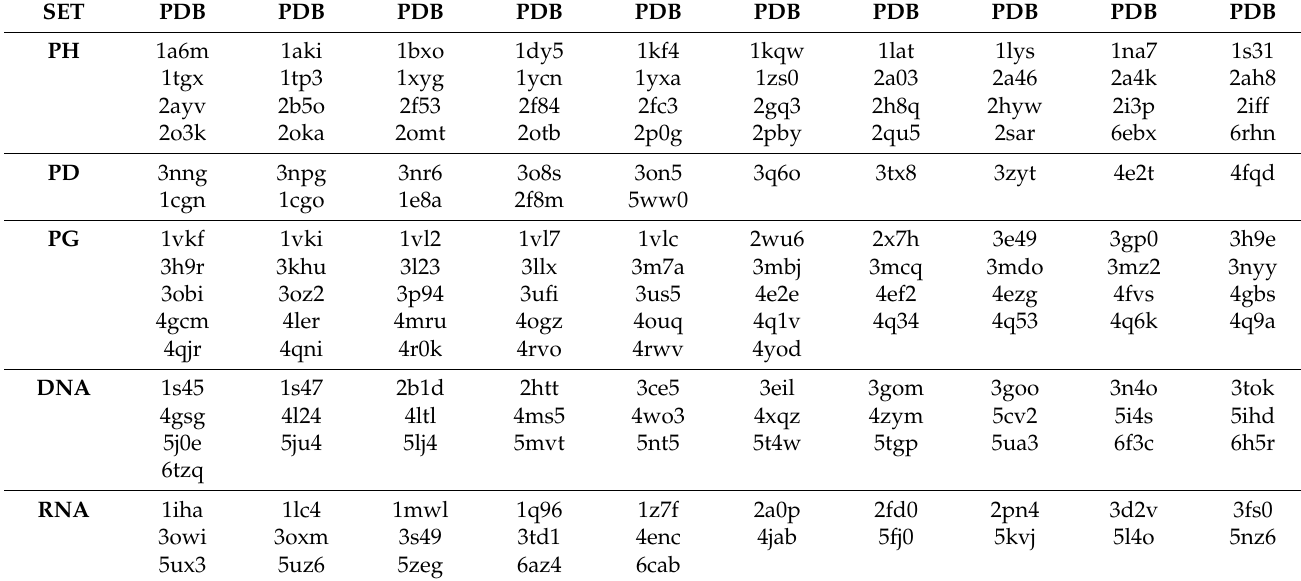
Table 1. PDB codes of test structures for MR applications, organized by set: PH, PD, PG, DNA and